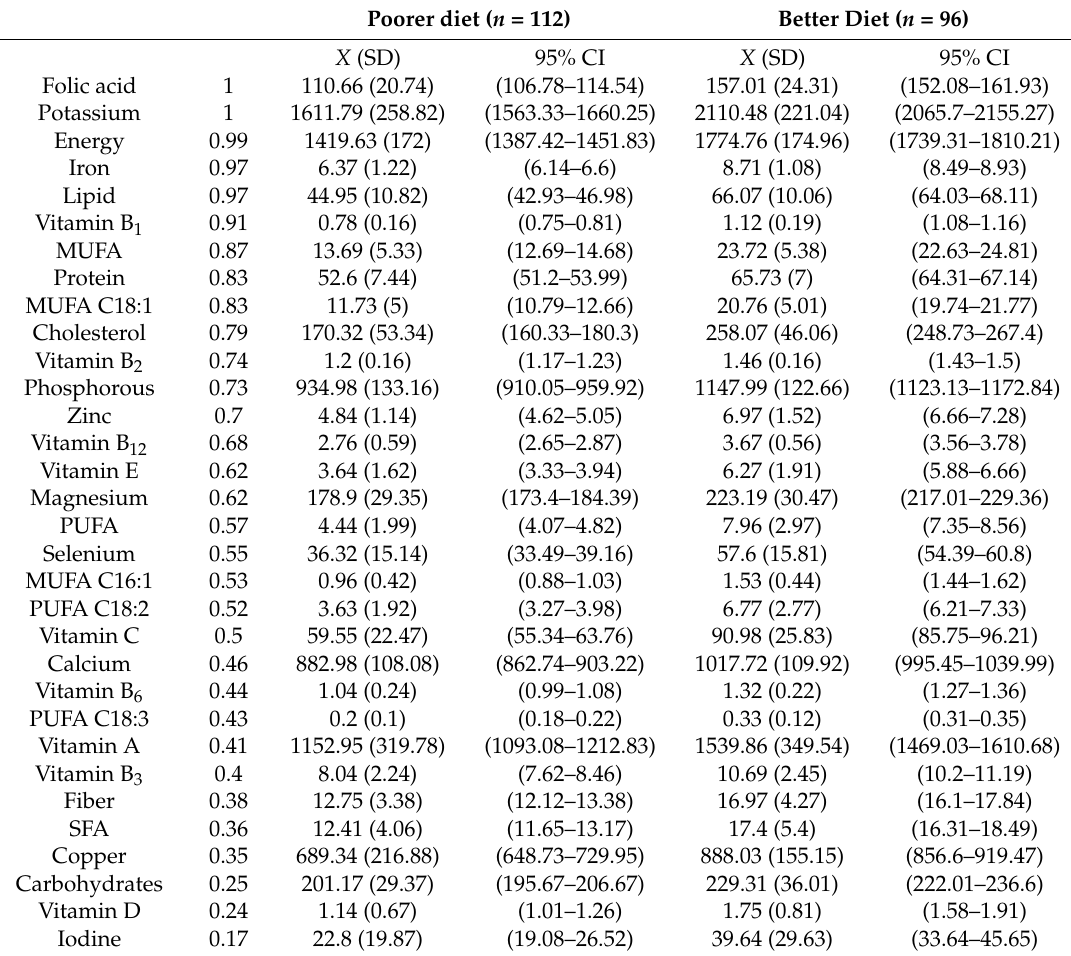
Table 3. Characterization of dietary patterns as a function of intake variables in order of